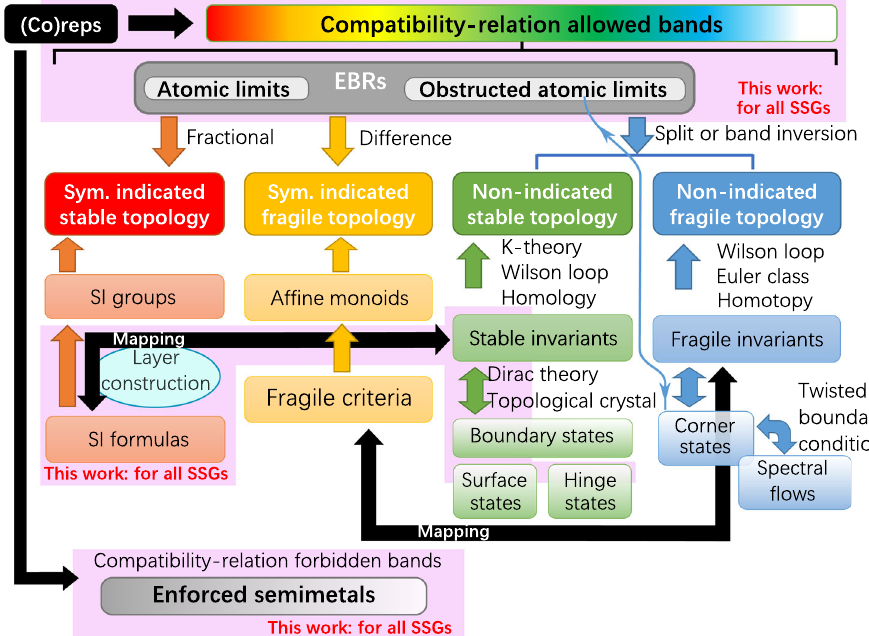
Fig. 2 Magnetic Topological Quantum Chemistry in the scheme of topological band theory. The complete scheme of topological band theory for 3D crystals, following the framework and notation established in refs. 5,6,31,66,67 . Through crystal symmetry eigenvalues [small (co)reps] in momentum space (SN 13), the compatibility relations (SN 16) indicate whether a set of bands is allowed by symmetry to be energetically isolated from other bands in the energy spectrum. If the bands are energetically isolated, then there exists a wide range of methods for diagnosing whether the bands exhibit the stable topology of topological insulators (TIs) and TCIs 17 – 20,23 – 34,54 , fragile topology 52,54,55,64 – 67 , or the polarization-nontrivial topology of obstructed atomic limits 5,54,84 . For example, as detailed in refs. 7,30 – 32,51,66,67 , the small (co)reps of a set of isolated bands comprise momentum-space symmetry data that can be mapped to position-space topology and boundary states through stable and fragile SIs and real-space invariants. If the bands are instead required by symmetry to cross, then the bands characterize a topological SM, which may exhibit surface 38 or hinge 34,54 states. In this fi gure, the pink boxes indicate areas of topological band theory completed in this work.